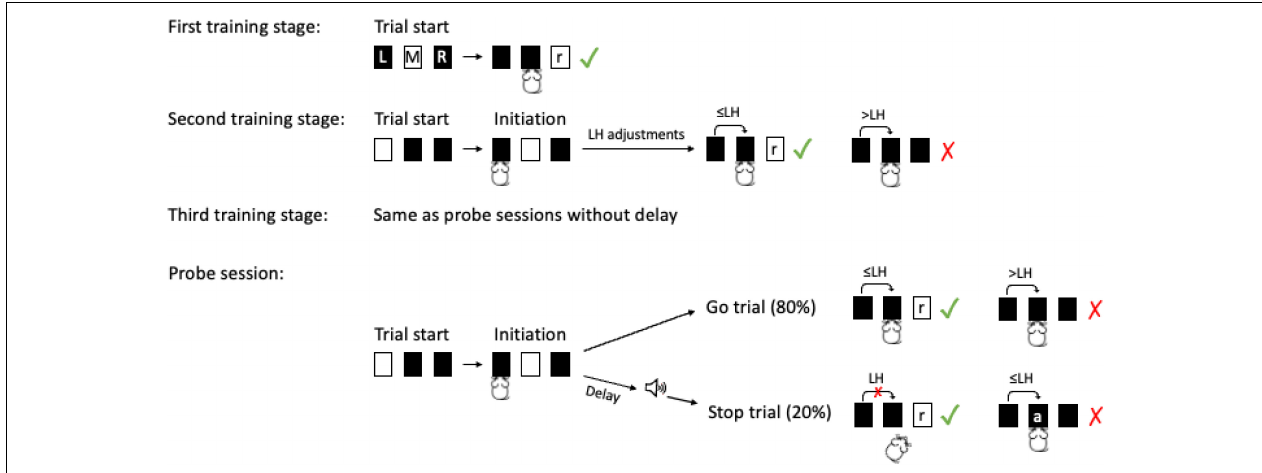
FIGURE 2 | Stop signal task training and testing stages. First training stage: mice had to perform a nose to the illuminated response port (M) to receive a reward (r) from the right port (R). There was no time limit for this response. Second training stage: Upon trial start mice had to poke the initiation port (L). There was no time limit for this response. After the initiation poke mice had to poke M within a limited hold duration (LH) to successfully complete the go response and receive a reward. At this stage LHs were individually adjusted to train fast go responses. Third training stage: a stop signal was presented in 20% of trials immediately upon poke onset to the initiation port. In stop trials, a poke to the response port within LH was negatively reinforced by an air puff (a). If instead, the mouse suppressed the poke to the response port it was rewarded with a pellet after the LH. Probe sessions: Delays between the poke to the initiation port and the stop signal were introduced. The delays were individually set relative to an individual‘s mean reaction time from the previous day (75, 150, and 300 ms before the mean reaction time). In each stop trial, there was an equal probability (0.33) to receive one the three different delay durations (mouse icon from Selman Design, CC